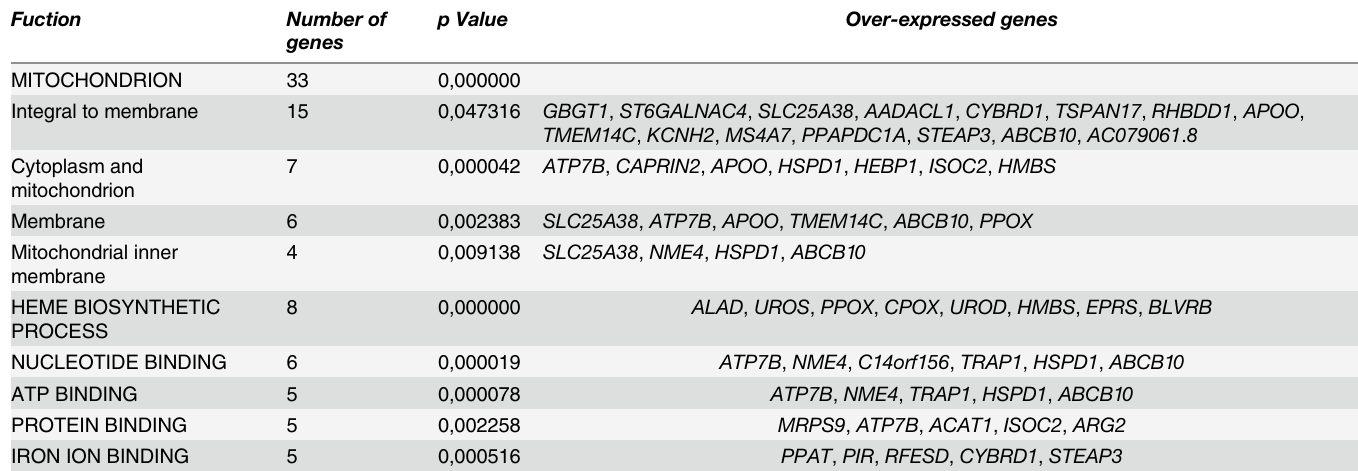
Table 2. Most representative deregulated cellular functions in RARS patients respect to the RCUD